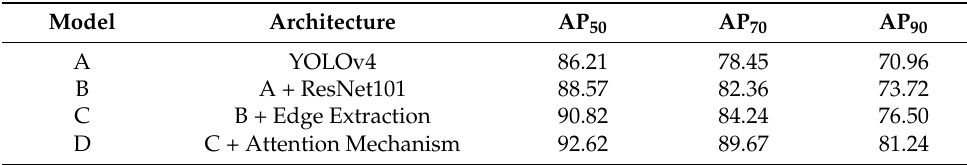
Table 8. The results of the ablation